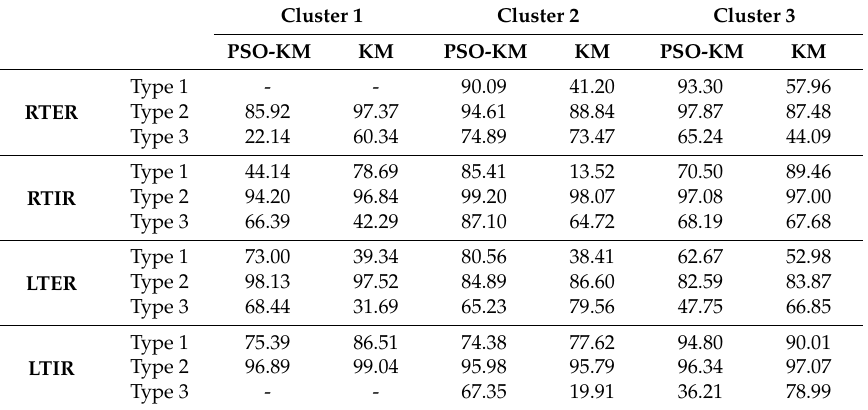
Table 6. Comparison of the PSO-KM and KM algorithms through general accuracy